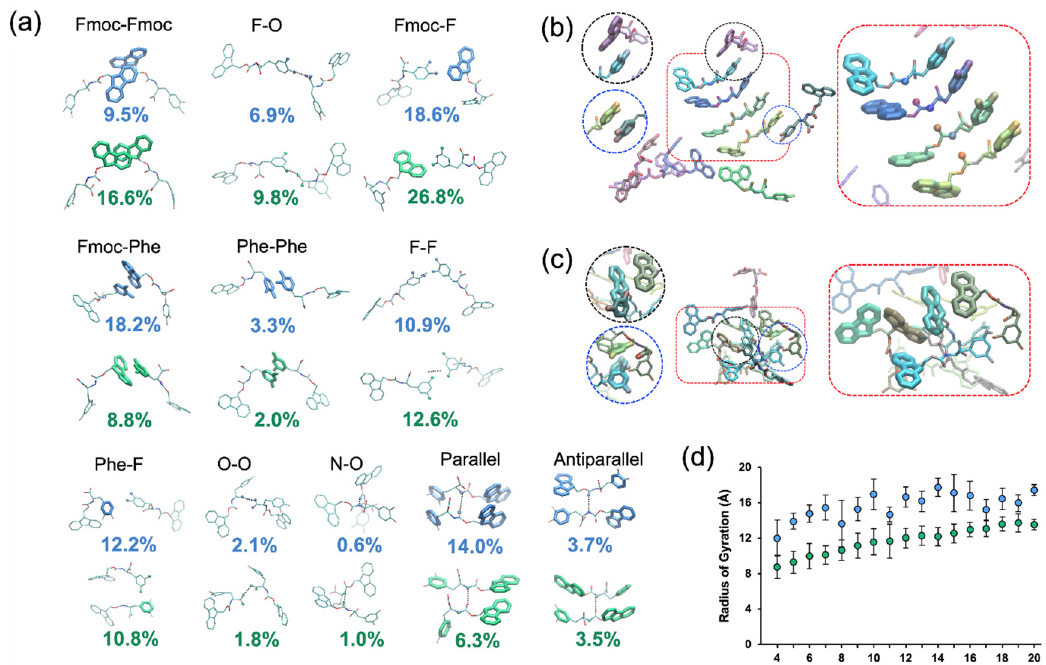
Figure 6. MD simulations depicting the structural properties of the Fmoc-3,4F-Phe and Fmoc-3,5F-Phe assemblies. ( a ) Molecular graphics images of interactions between (top row, blue) Fmoc-3,4F-Phe and (bottom row, green) Fmoc-3,5F-Phe pairs observed in simulations and their average percent frequency across all MD simulations. Percent frequency was calculated as the total number of instances for which a given interaction was observed, divided by the total number of interactions observed in each simulation. The average standard deviation of the average percent frequencies is 0.9 ± 0.6% with a minimum and maximum standard deviation of 0.1 and 2.6%, respectively; the relatively small values indicate good reproducibility across different simulation runs per system. ( b , c ) Representative aggregate of 10 ( b ) Fmoc-3,4F-Phe and ( c ) Fmoc-3,5F-Phe building-block monomers observed in the simulations with key differences in interactions encircled in dotted lines and zoomed-in in the nearby panels. Molecular graphics images in ( a – c ) were produced using Visual Molecular Dynamics (VMD) version 1.9.4 [50]. ( d ) Radius of gyration (Å) of building block-monomers within the clusters observed in the simulations of Fmoc-3,4F-Phe (blue) and Fmoc-3,5F-Phe